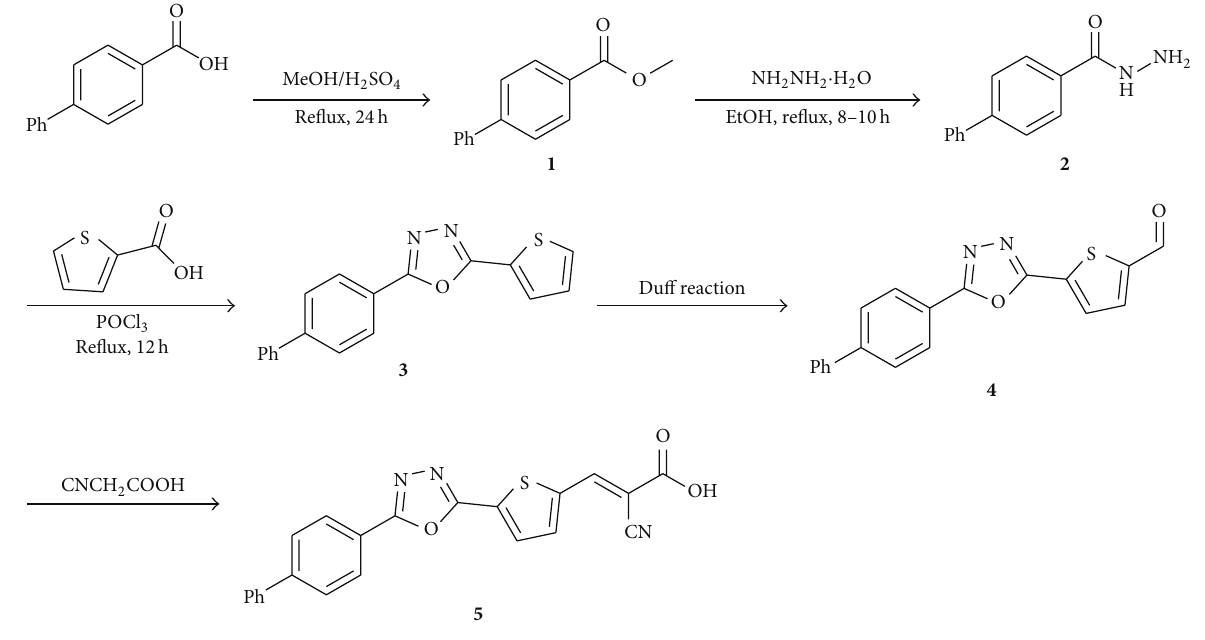
Scheme 1: Synthesis of novel